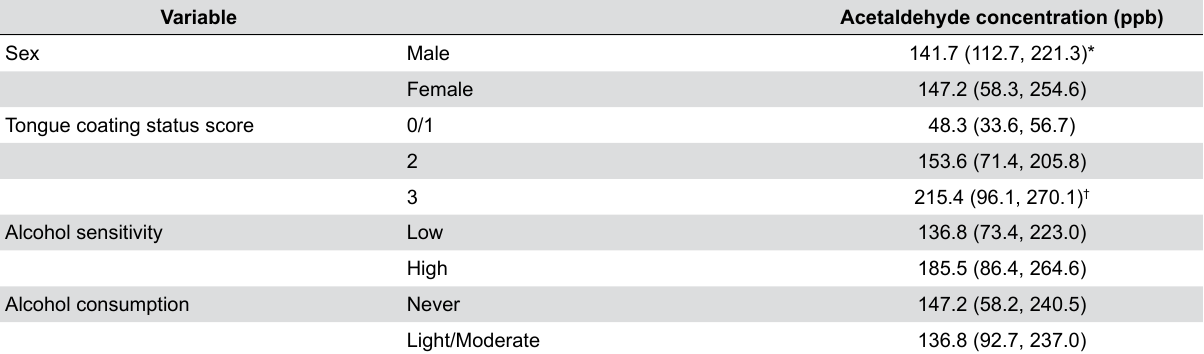
Table 2- Difference in acetaldehyde concentration in mouth air